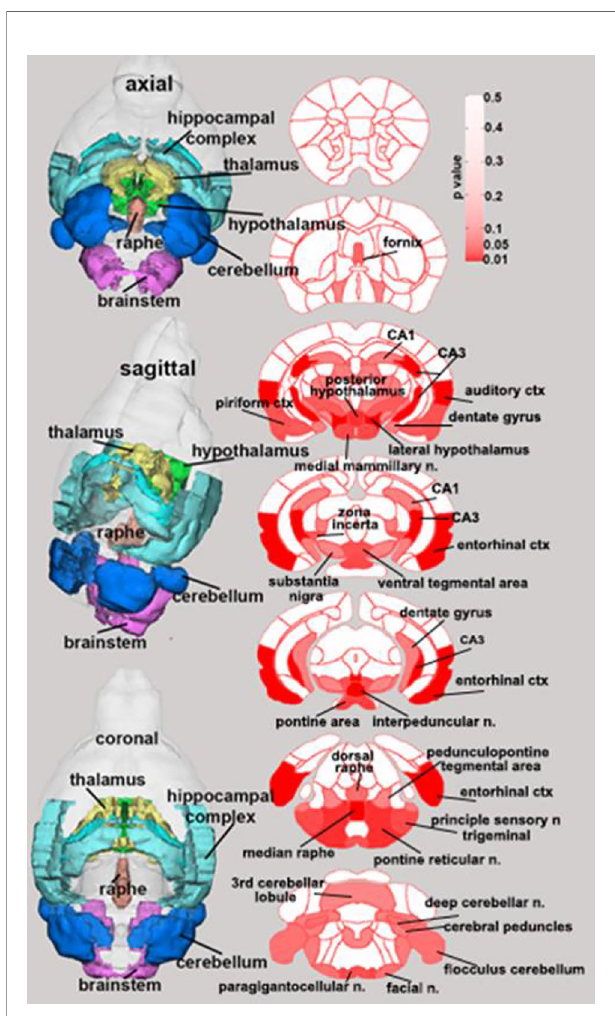
FIGURE 3 | Paclitaxel chemotherapy consistently increased fractional anisotropy following the fi nal dose in survivor mice. Axial, sagittal, and coronal views of fractional anisotropy probability maps calculated from diffusion weighted imaging are shown. Paclitaxel n=8, vehicle n=8. Unpaired parametric two-tailed t tests were used for statistical analyses. Nonparametric Mann-Whitney U tests were used when the assumptions of normality and equal variances were not